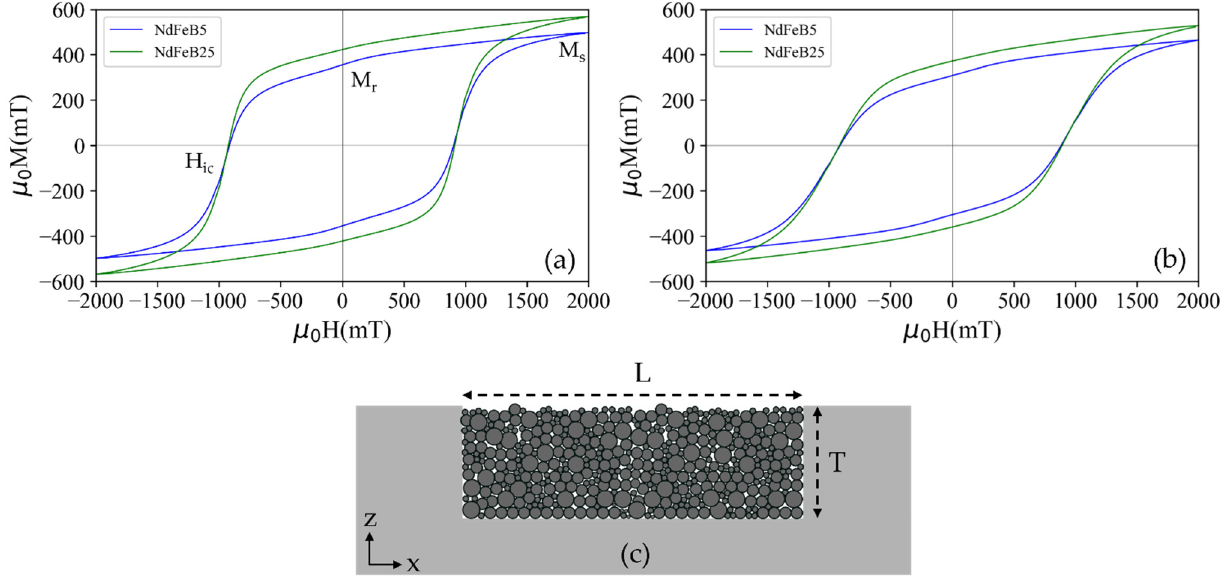
Table 1. Magnetic properties of the PowderMEMS NdFeB micromagnets with dimensions of